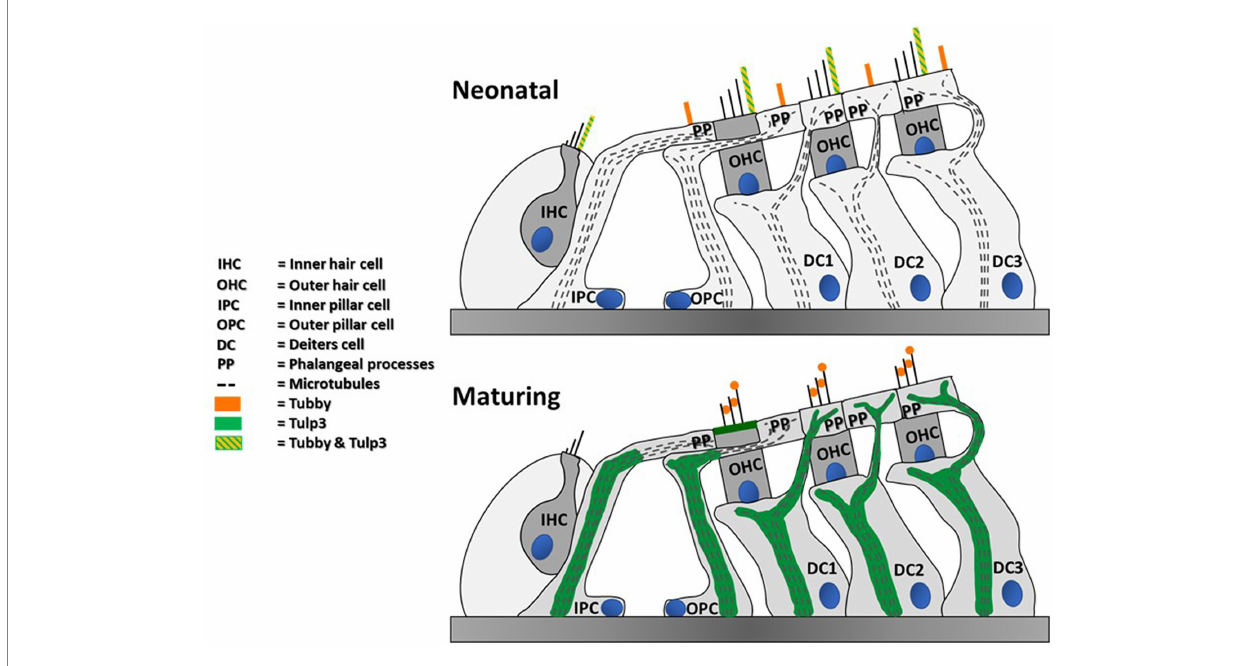
FIGURE 6 Summary of detected tubby & TULP3 immunoreactivity in the postnatal mouse cochlea. Blue circles represent